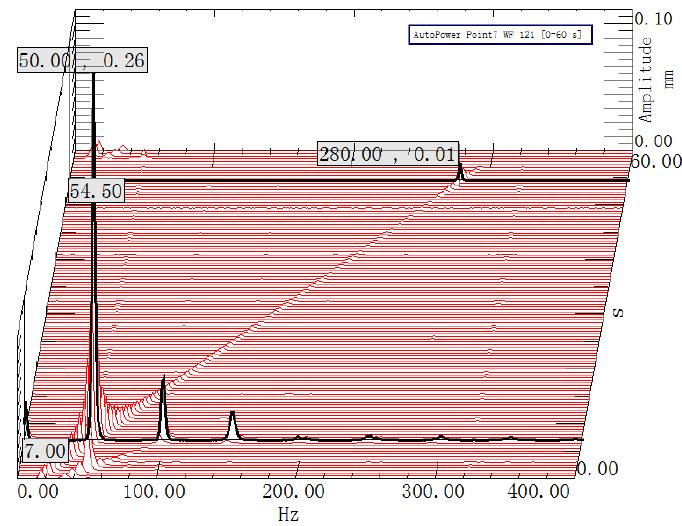
Figure 11. Sweeping frequency waterfall of the beam with open-circuit condition.